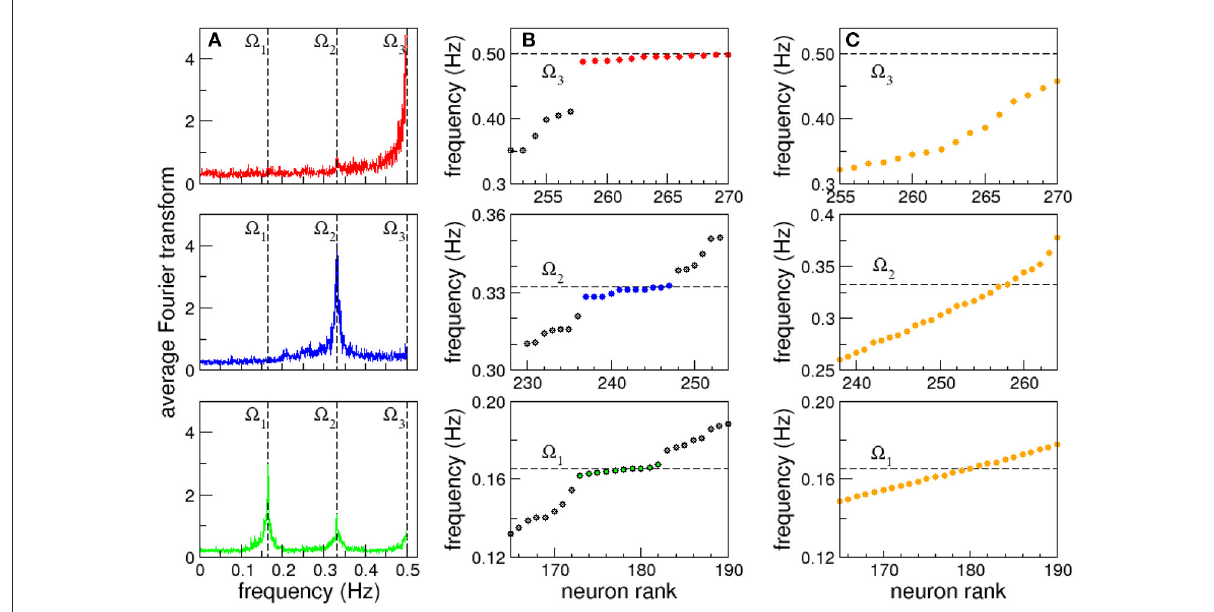
FIGURE2 Frequency synchronization. (A) Average Fourier transforms of neurons in three synchronized clusters for a full 15 min long experiment. (B) Neurons sorted from lower to higher characteristic frequency. Dashed lines are shown as a guide to the eye to show the characteristic frequency of the synchronized clusters that appear as horizontal lines. (C) Synchronized clusters are not observed in control experiments with randomized versions of the